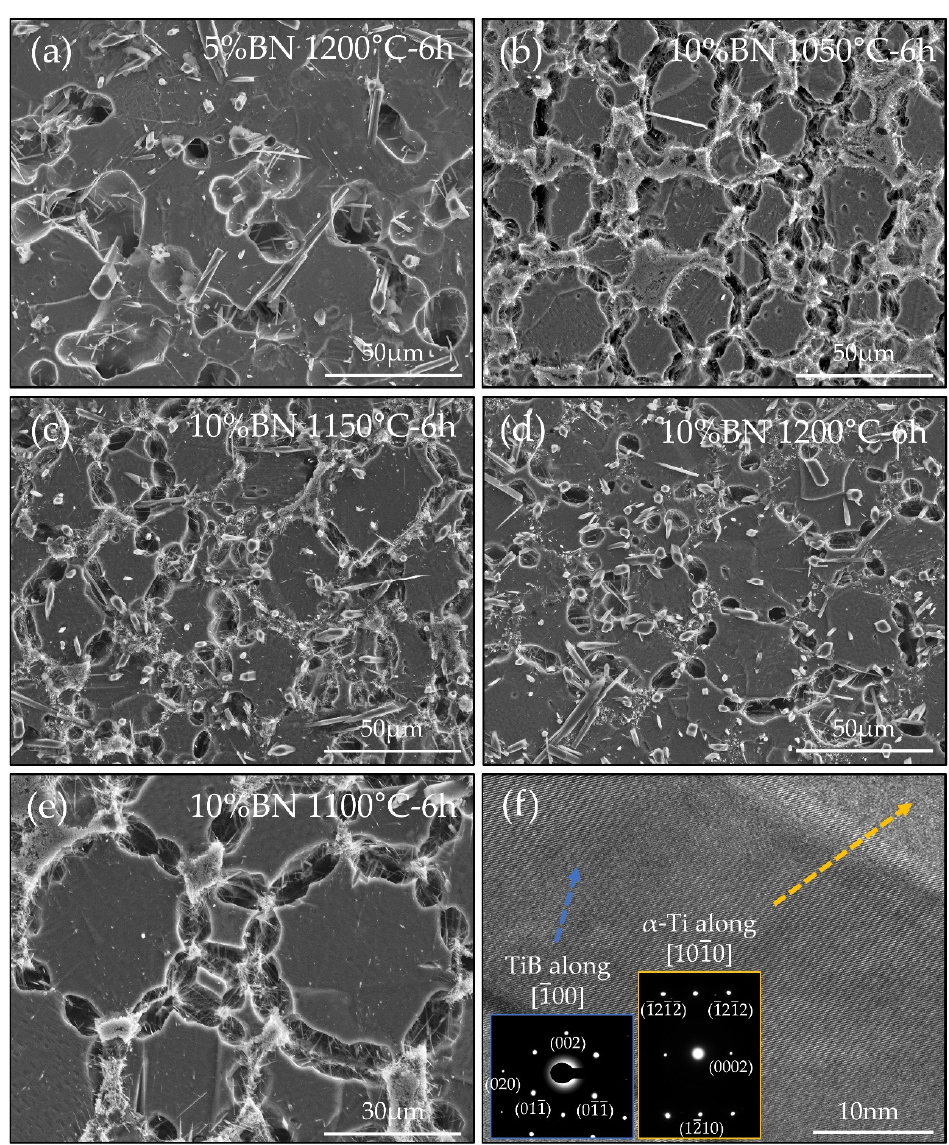
Figure 3. TEM and SEM images showing as-sintered TMC microstructure after etching: ( a ) SEM image of 5 vol% BN TMC sintered at 1200 °C for 6 h; ( b ) SEM image of 10 vol% BN TMC sintered at 1050 °C for 6 h; ( c ) SEM image of 10 vol% BN TMC sintered at 1150 °C for 6 h; ( d ) SEM image of 10 vol% BN TMC sintered at 1200 °C for 6 h; ( e ) SEM image of 10 vol% BN TMC sintered at 1100 °C for 6 h; ( f ) TEM image of FIB cut lamella from 10 vol% BN TMC sintered at 1100 °C for 6 h with inset indexed selected area electron diffraction patterns of TiB and α -Ti.